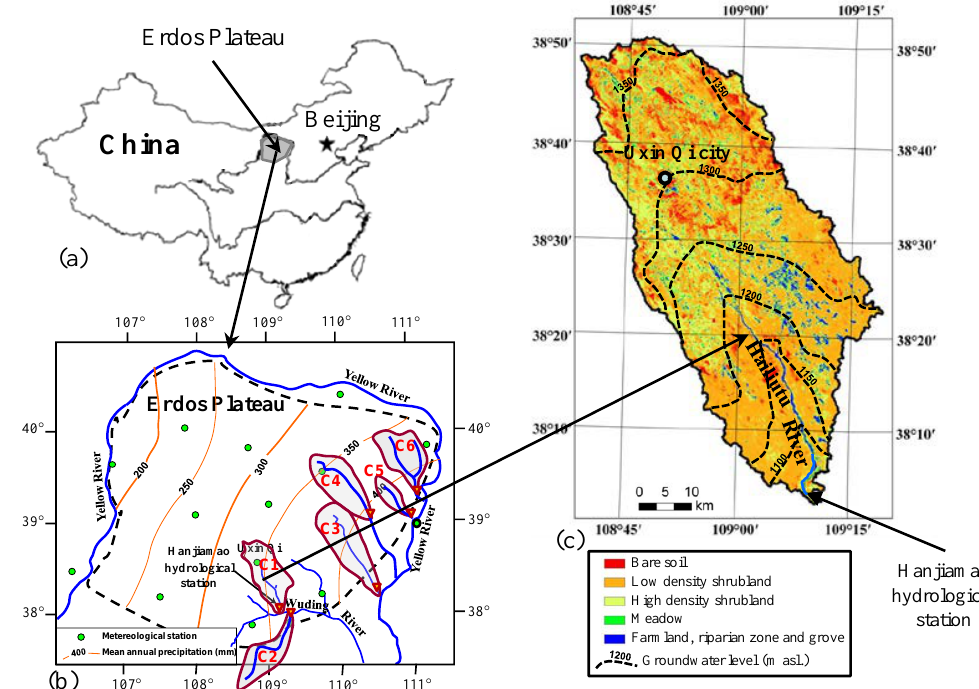
Figure 1. Geographic information of the study site: (a) location of the study area in northern–central China; (b) distribution of meteorological stations in the Erdos Plateau (green points) and the study catchments numbered C1–C6. (c) Characteristics of landscape in catchment C1 (the Hailiutu River catchment) according to Lv et al.